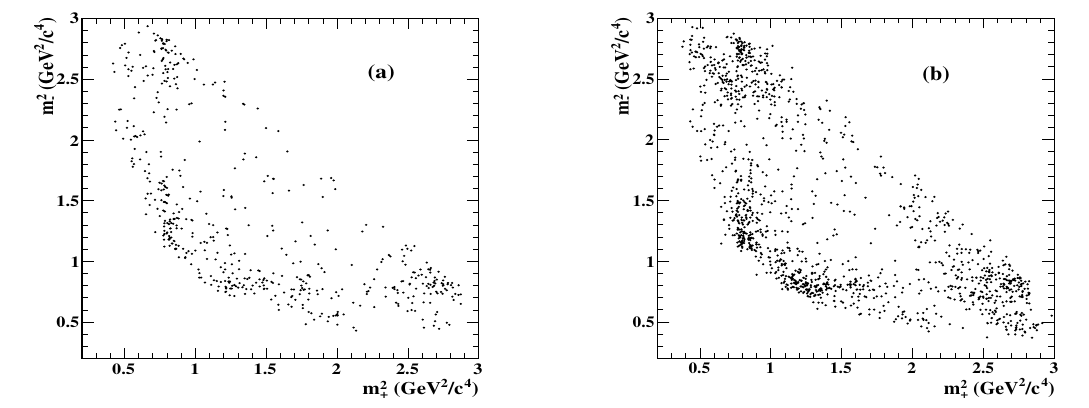
(cid:25) + (cid:25) (cid:0) and (b) K 0 S